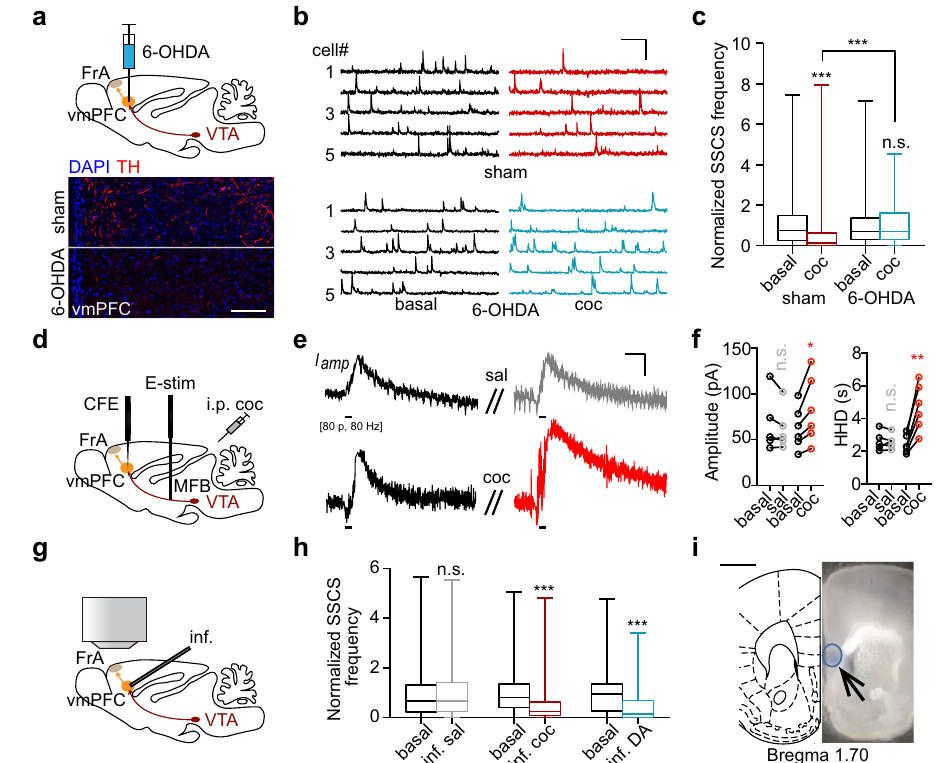
Fig.4|DopaminergicprojectiontothevmPFCisnecessaryforcocaine-induced hypoactivityofthe FrA. a Upper,schematicof6-OHDA injection into the vmPFC. Lower, TH-staining (red) showing the depletion of dopaminergic terminals in the vmPFC through 6-OHDA microinjection. Cal-520 was used for Ca 2+ imaging in the FrA.Scalebar,100 µ m. b , c Representativetraces(scalebars:20s,200%dF/F 0 )and normalized SSCS frequency (minimum, maximum, and three quartiles) of FrA neurons as in ( a ). Sham, n =406 neurons from seven mice; 6-OHDA, n =397 neu- rons from sevenmice( p =0.77),two-tailed Wilcoxon test forpaired and two-tailed Mann – Whitneytest forunpaired comparison. d Invivo amperometric CFE(carbon fi ber electrode) recording of dopamine (DA) release in the vmPFC in response to electricalstimulation(E-stim,1ms,80pulsesat80Hz)intheMFB(medialforebrain bundle). e , f Representative amperometric traces ( I amp , scale bars: 2s, 30pA) and